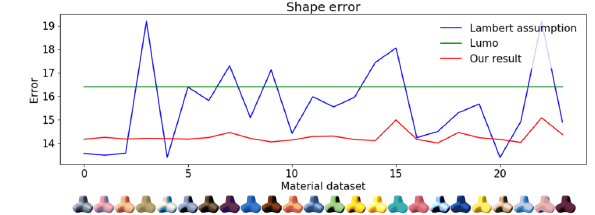
Fig. 12 Errors of estimated shape depending on input material (simple shape Three Box ).